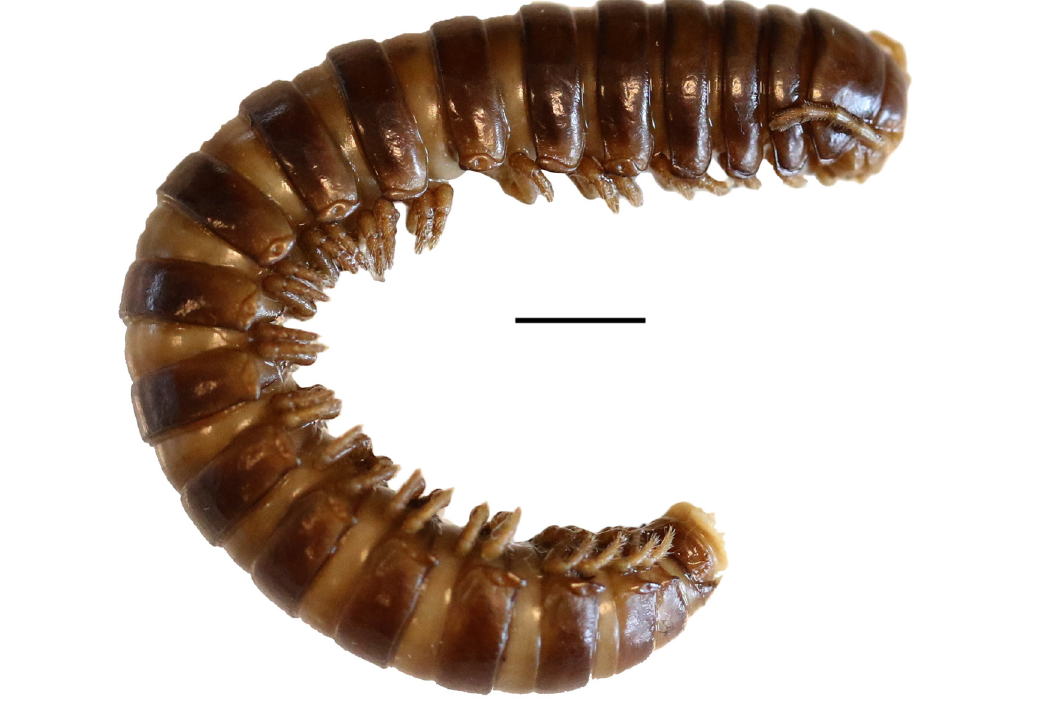
Fig. 10. Pogoro siren Rosenmejer & Enghoff sp. nov., holotype, ♂ (NHMD 621674). Scale bar: 5